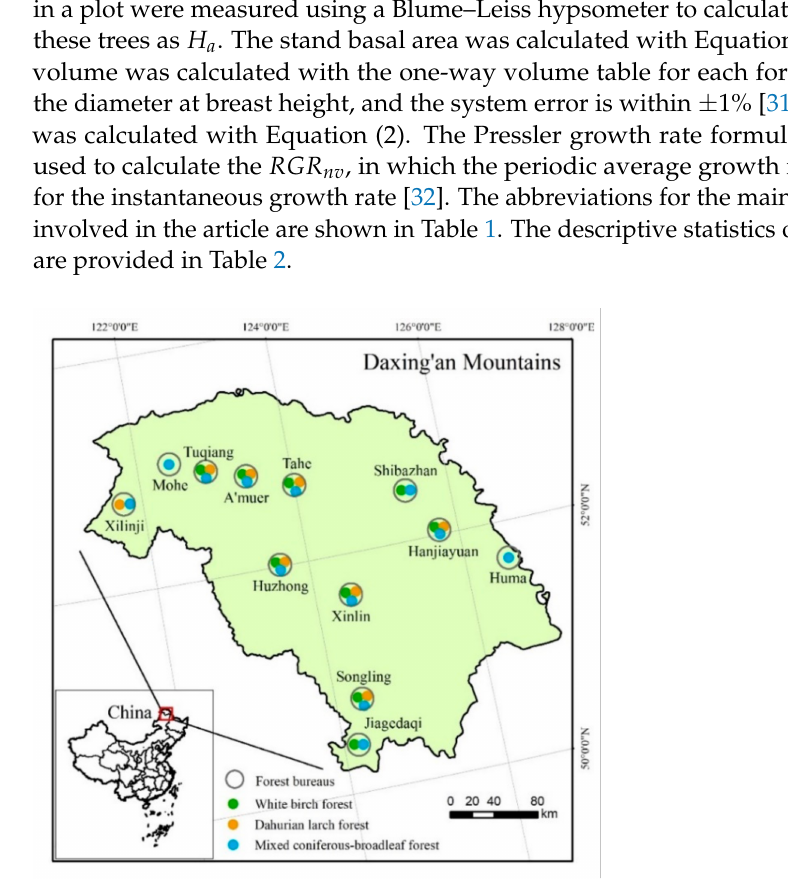
Figure 1. The geographical position of the study area and the forest bureaus (regions) in eastern Daxing’an Mountains, Northeast China.